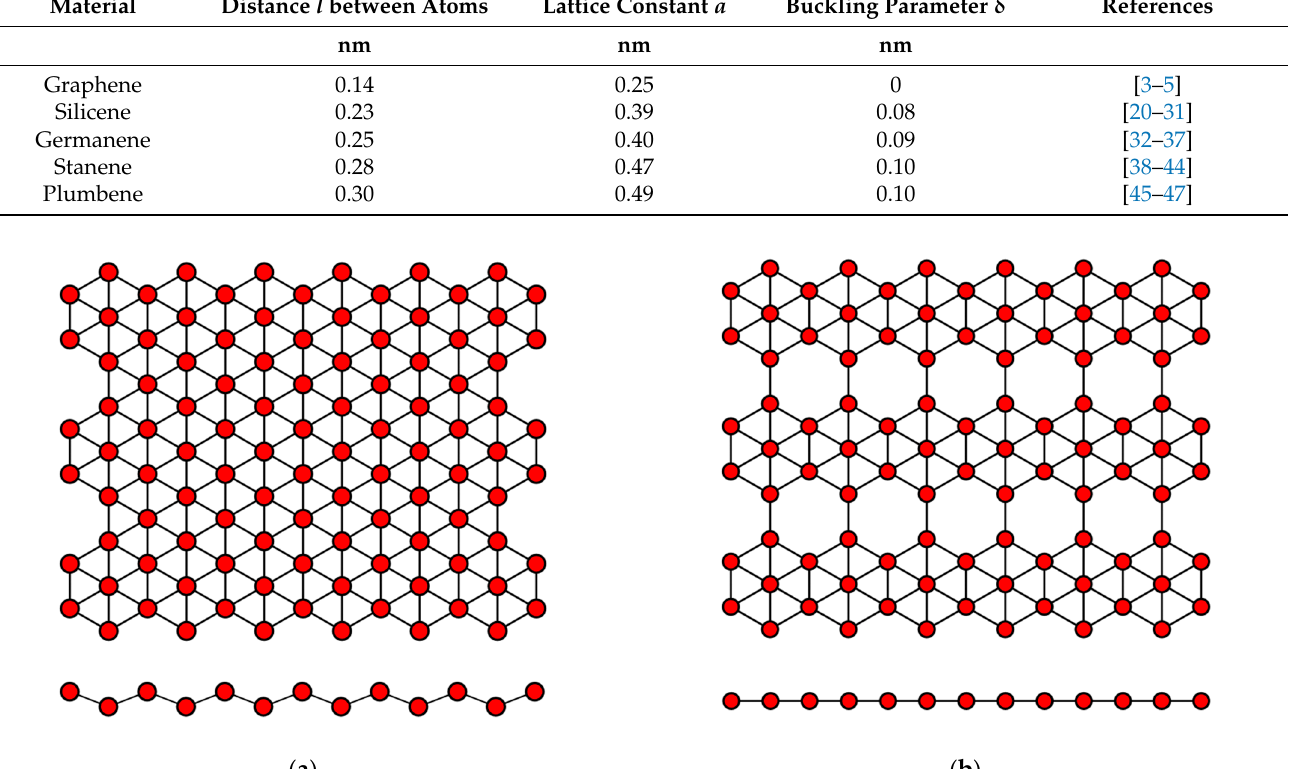
Figure 3. Variants of the structure of the crystal lattice of borophene for ( a ) v = 0 and ( b ) v = 1/6. Gallenene has a flat honeycomb structure similar to graphene (Figure 2a), or a slightly